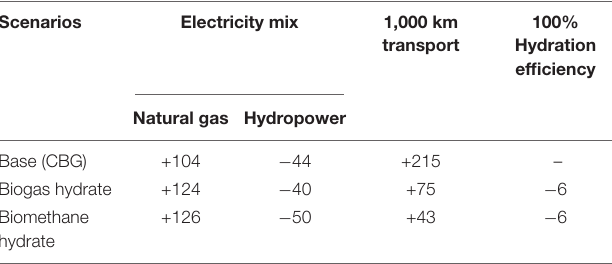
TABLE 6 | Change (%) in primary energy (PE) input per functional unit when selected input parameters were changed in the three scenarios studied. Scenarios